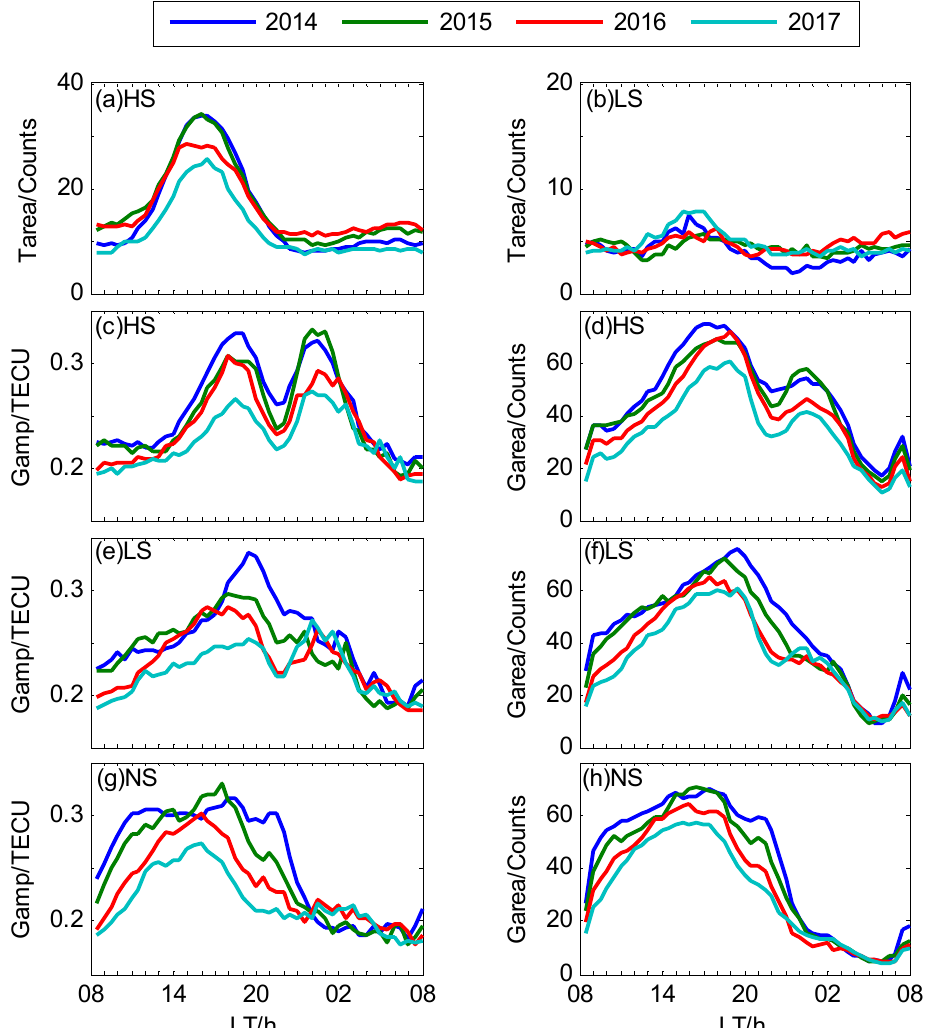
Figure 5. Annual variation of diurnal averages of thunderstorm activity and ionospheric GW activity. ( a ) Thunderstorm coverage on HS days; ( b ) thunderstorm coverage on LS days; ( c ) ionospheric GW magnitude on HS days; ( d ) ionospheric GW coverage on HS days; ( e ) ionospheric GW magnitude on LS days; ( f ) ionospheric GW coverage on LS days; ( g ) ionospheric GW magnitude on NS days; ( h ) ionospheric GW coverage on NS days.